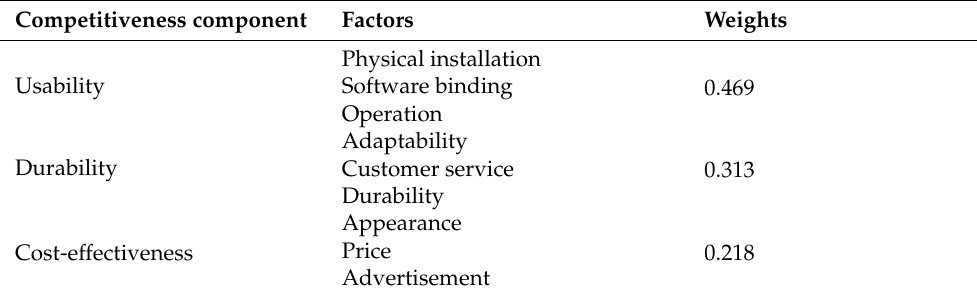
Table 5. GED competitiveness components